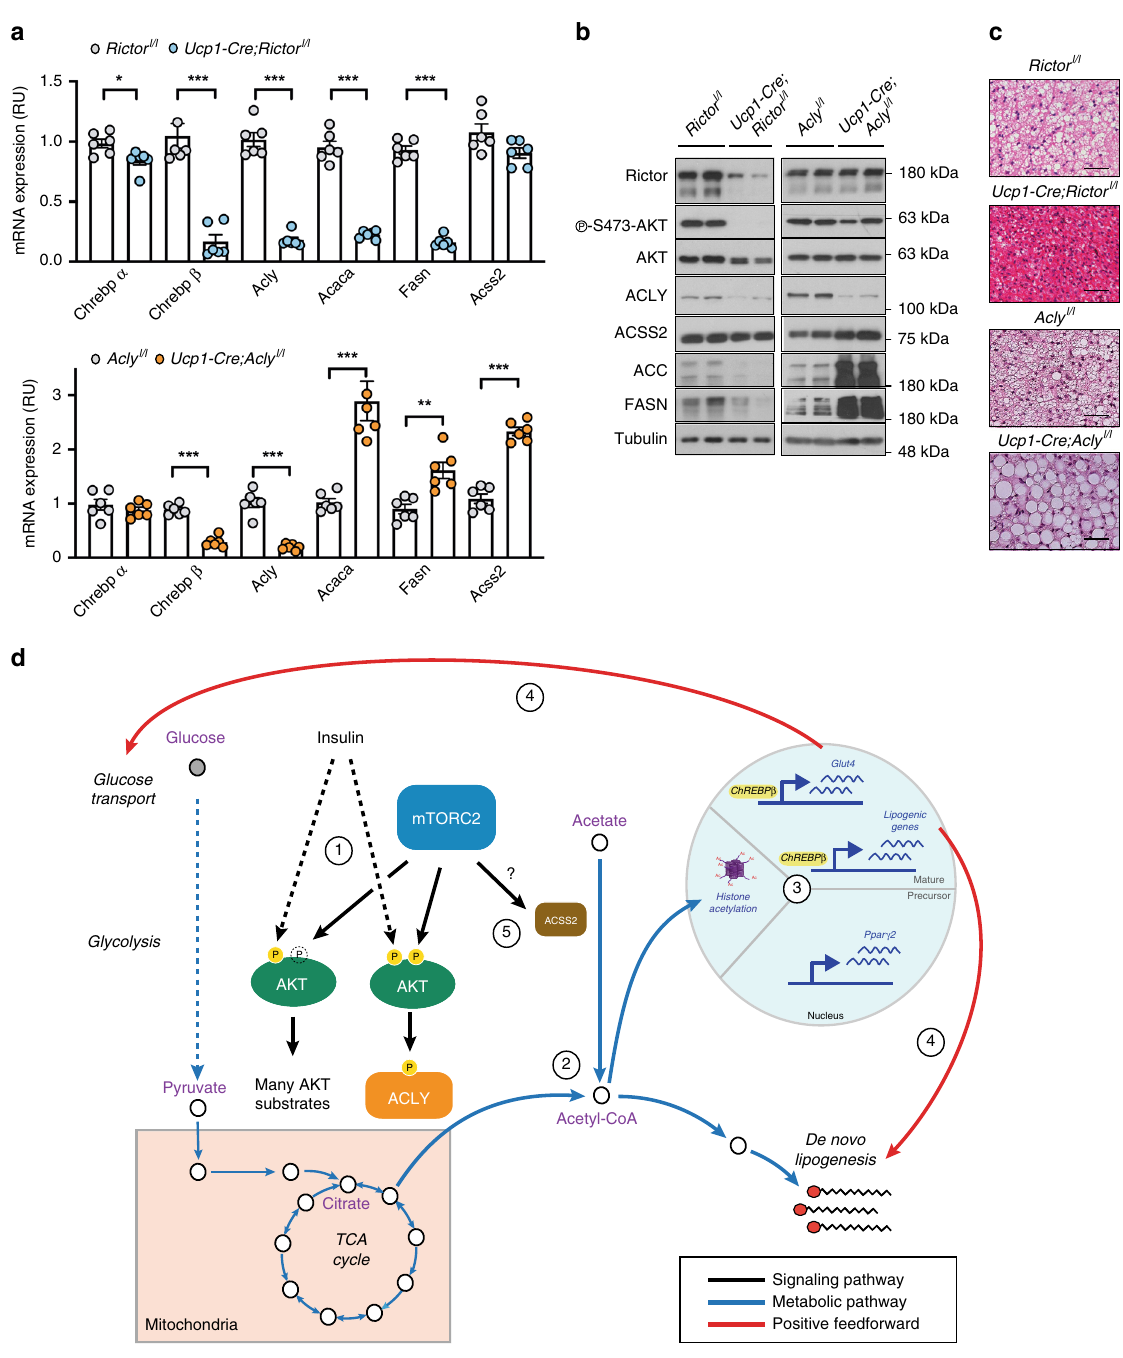
Fig. 7 In vivo, mTORC2 and ACLY both promote ChREBP β expression, but their loss has opposite effects on ACC and FASN expression that correlates with differential ACSS2 regulation. a qRT-PCR analysis of the indicated genes in brown fat tissue isolated from control ( Rictor l/l and Acly l/l ) or UCP1-Cre- Rictor l/l and UCP1-Cre-Acly l/l mice ( n = 6 per group). Bar graphs represent mean ± SEM. * p < 0.05, ** p < 0.01, and *** p < 0.001. Statistical signi fi cance was calculated by using two-way ANOVA with Sidak ’ s test multiple comparisons ( a ). b Corresponding western blots for a . Black arrows indicate the ACC1 and ACC2 isoforms. c Hematoxylin and eosin stains showing brown fat morphology for the indicated genotypes. Scale bar represents 200 μ m. d Our results support the following model of mTORC2 action in brown adipocytes: (1) mTORC2-dependent AKT phosphorylation is distinctly important for ACLY phosphorylation, while for many other AKT substrates, mTORC2 may normally facilitate their phosphorylation, but it is dispensable (indicated by “ P ” within an unshaded broken circle). This is indicated by the fact that phosphorylation of many AKT substrates is unimpaired by Rictor deletion while ACLY phosphorylation is reduced. (2) mTORC2/AKT-dependent ACLY phosphorylation promotes acetyl-CoA synthesis and primes de novo lipogenesis downstream of glucose uptake and glycolysis. (3) The increased fl ux to acetyl-CoA additionally stimulates histone acetylation. In brown adipocyte precursors, this coincides with ppar γ induction to drive differentiation; in mature brown adipocytes, this coincides with ChREBP β activity to increase expression of gluco-lipogenic genes. (4) Gluco-lipogenic gene expression then provides a positive feedback effect on glucose transport and de novo lipogenesis. (5) mTORC2 may also stimulate acetate metabolism to acetyl-CoA by regulating the expression and/or activity of ACSS2. Notably, from these data we cannot distinguish between cytoplasmic and nuclear pools of